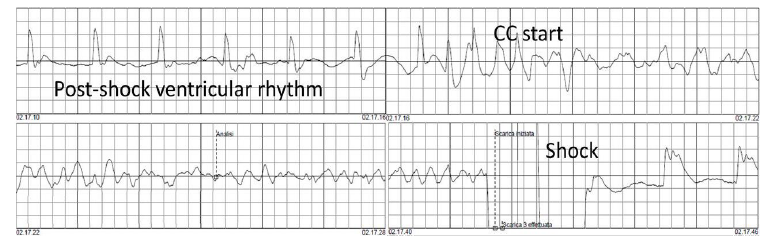
Medicina 2021 , 57 , x FOR PEER REVIEW Figure 1. VF recurrence during chest compressions. Figure 1. VF recurrence during chest compressions.